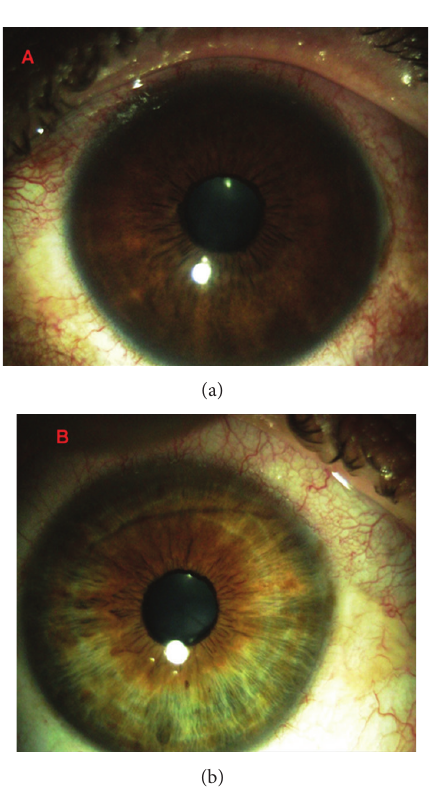
Figure 2: Slit-lamp photographs show folding on the iris, more prominent in the pupil area in the right eye (mammillations) (a). The darker iris in the right eye compared to the blue iris of the left eye (b) (heterochromia iridis).